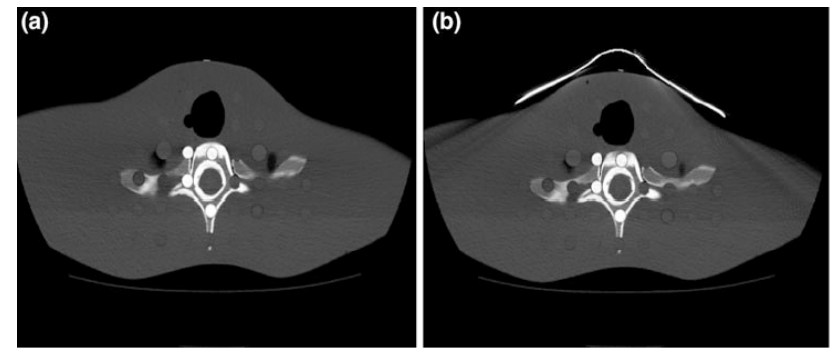
Figure 3. Axial Cervical CT Images: (a) Without and (b) With Bismuth Shielding Over the Neck in a Female Phantom. Note . CT: Computed tomography. Copyright permission was obtained from the author and the editor for applying these